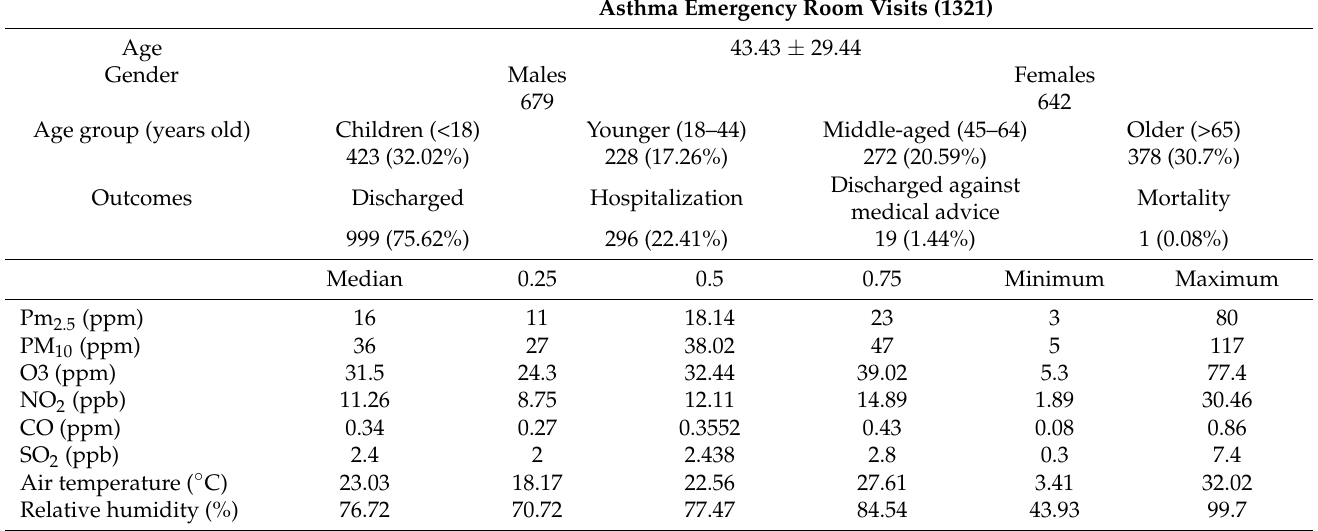
Table 1. The asthma emergency room visits, air pollutants and meteorological factors in Longtan district over 4 years (2016–2019).